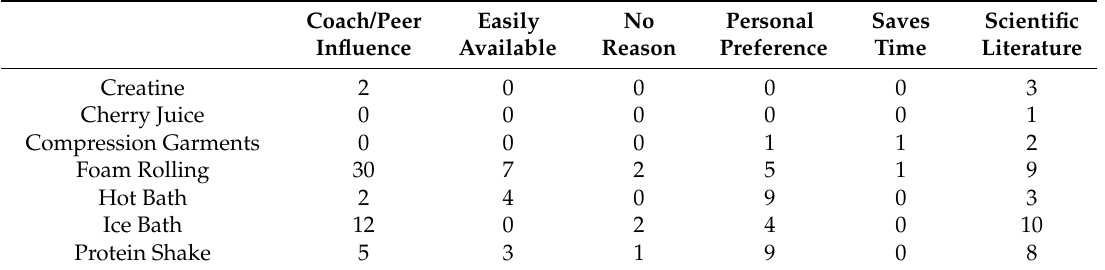
Table 1. Reasons for recovery strategy use, expressed as individual